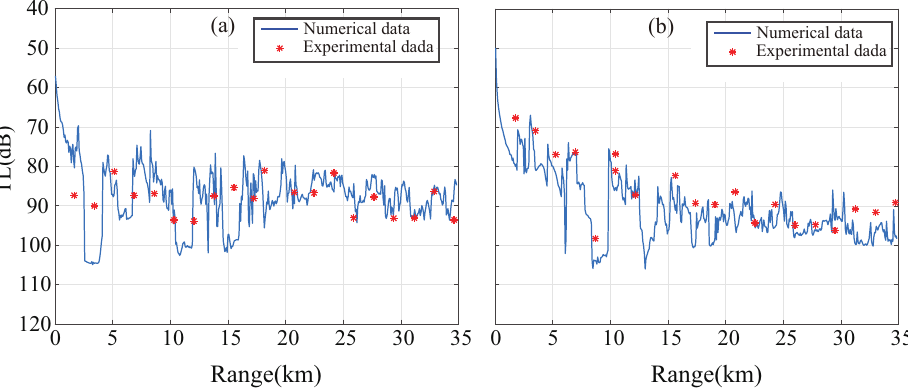
Figure 18. Comparison of Transmission Losses between numerical and experimental results for 175 m depth of hydrophone, ( a ) explosive source at depth 100 m and ( b ) at 200